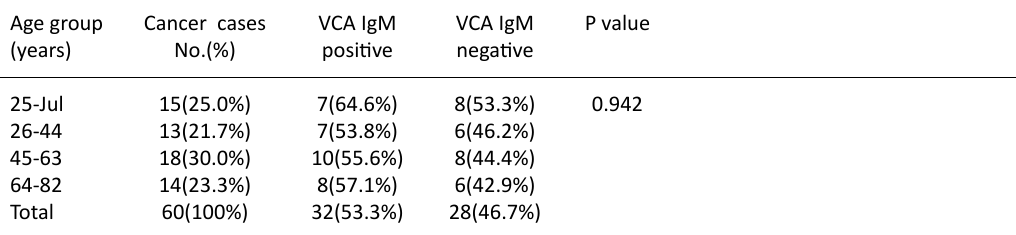
Table 7. Serological identification of (EBNA1,EBNA2) depending on age groups of female patients Age Cancer ENBA 1 EBNA 2 P value groups